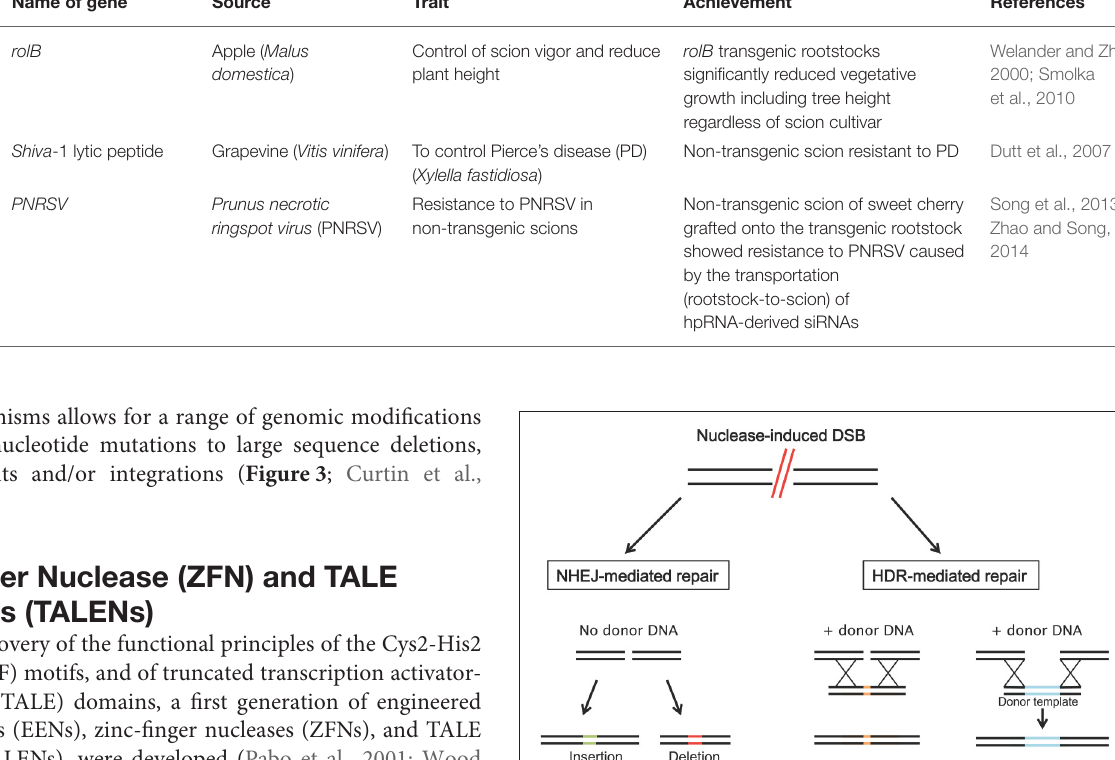
TABLE 3 | Applications of trans-grafting in woody fruit species. Plant species